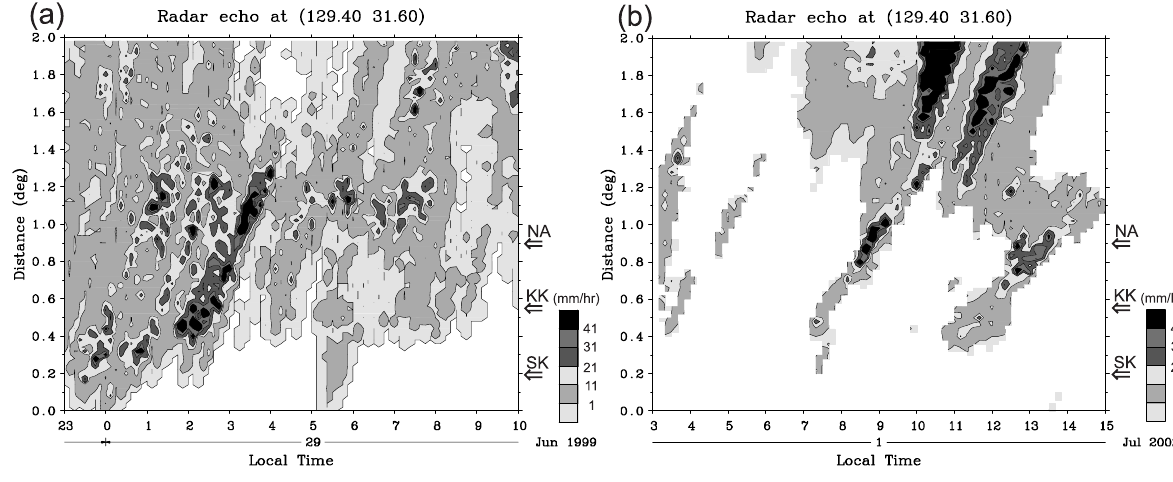
Fig. 7. The same as Fig. 6 but observed by JMA operational radars at 2km altitude on ( a ) 29 June 1999 and ( b ) 1 July 2002.